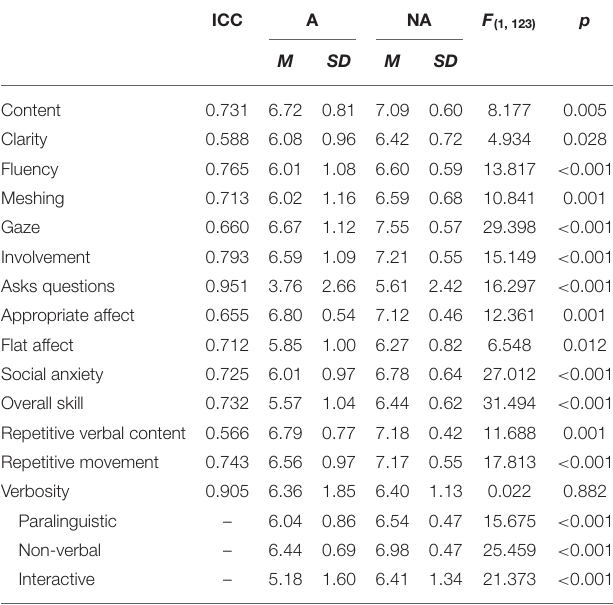
TABLE 2 | Means and group comparison of social